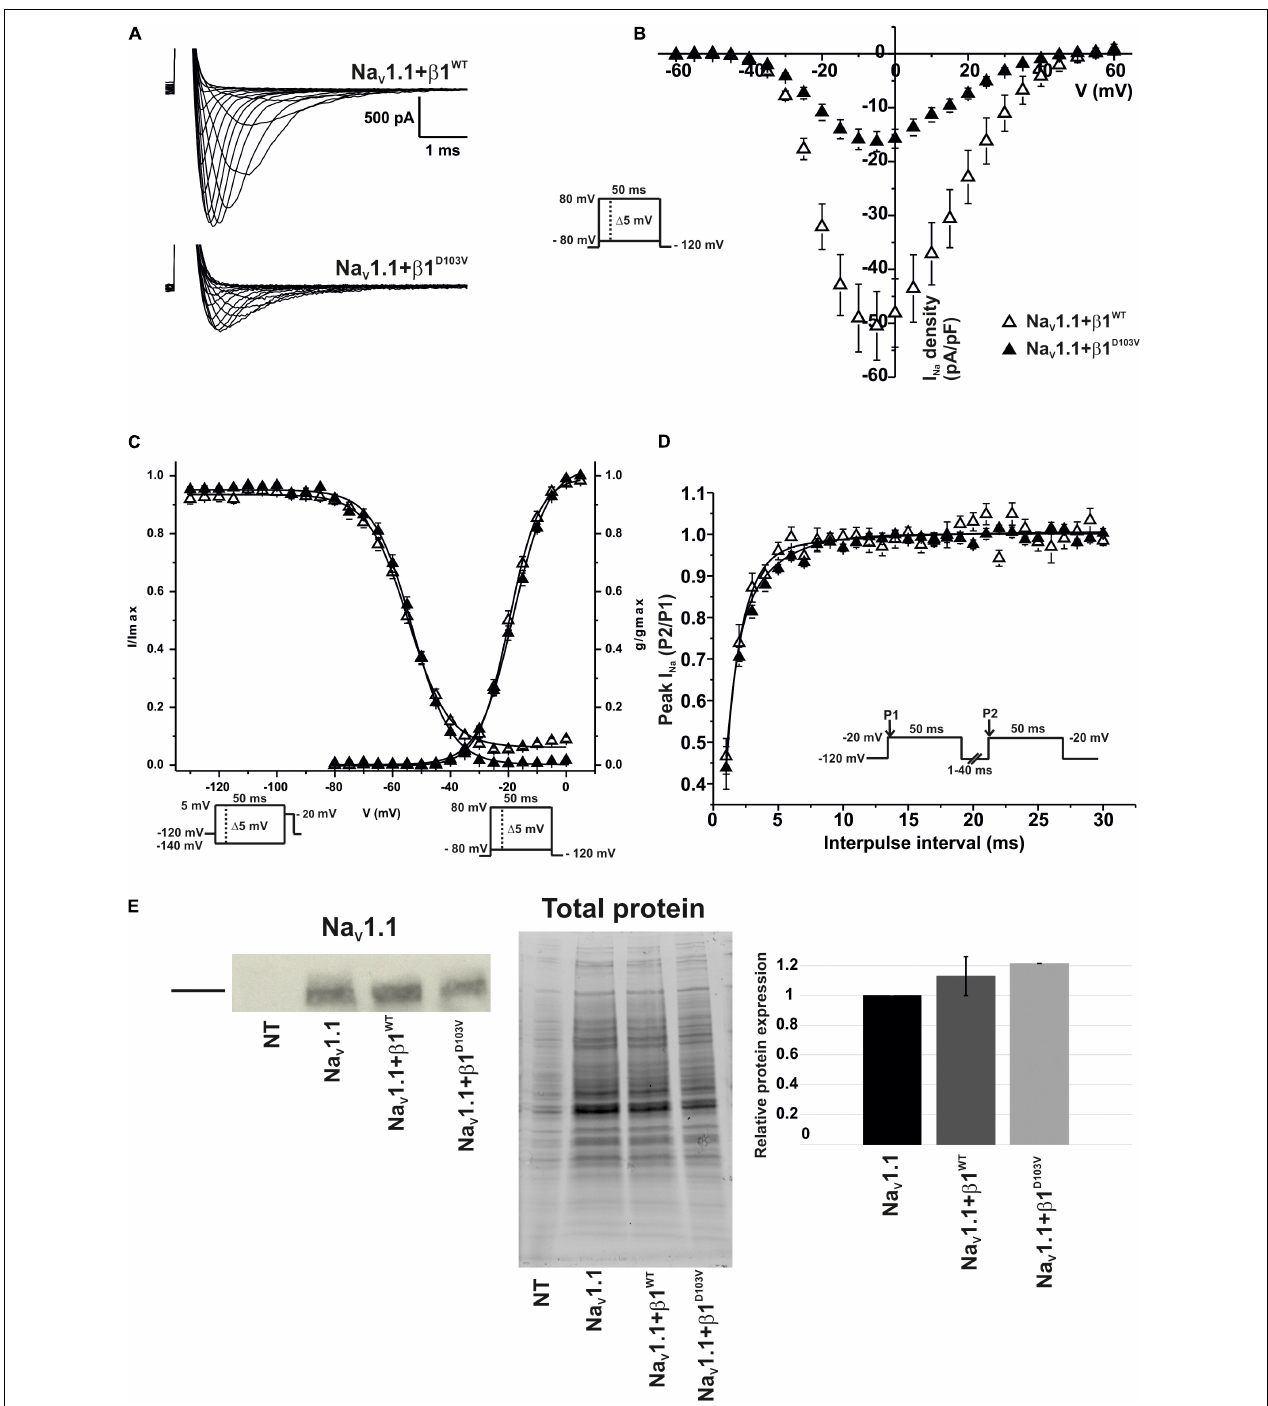
FIGURE 7 | β 1 D103V significantly decreases peak I Na on Na V 1.1. Biophysical properties of sodium currents measured from HEK-293T cells expressing Na V 1.1 co-expressed with either β 1 WT or β 1 D103V . Whole cell currents were elicited by depolarizing potentials as shown in the insets. Open triangles are used to depict data for Na V 1.1+ β 1 WT and filled triangles for Na V 1.1+ β 1 D103V . Solid lines in panels (C) and (D) represent the fitted curves. Values are expressed as mean ± SEM. (A) Representative whole-cell Na + current traces from HEK-293T cells expressing Na V 1.1+ β 1 WT (top), and Na V 1.1+ β 1 D103V (bottom). (B) Mean current-voltage relationship. I Na amplitude was normalized by the cell capacitance to obtain I Na density values. (C) I Na steady-state voltage dependence of activation and inactivation plots. (D) Recovery from inactivation curves. (E) Western blot detection of Na V 1.1 (left) and corresponding total protein stain-free gel (middle), from HEK-293T cells transfected with either Na V 1.1, Na V 1.1+ β 1 WT , or Na V 1.1+ β 1 D103V or non- transfected cells (NT). Bar graph on the right depicts the relative protein expression normalized by the Na V 1.1 alone ( n =